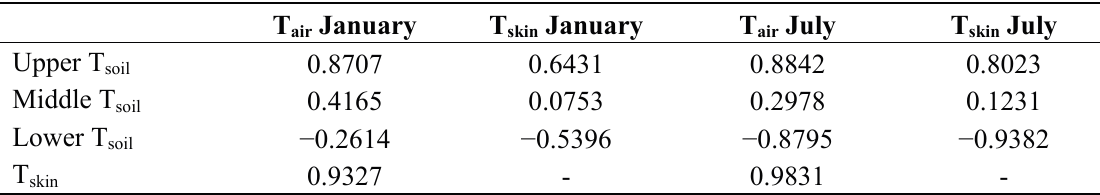
Table 1. Correlation Coefficients based on 2003–2008 monthly mean observations. The correlation coefficients are based on hourly-averaged temperatures for each day of the month between 2003–2008 ( n =